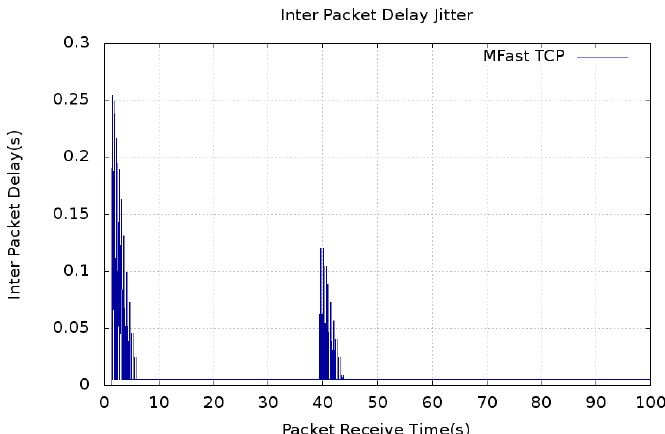
Figure 3. Inter-packet delay (IPD) jitter of Multistream Fast Transmission Control Protocol (MFast TCP) during the simulation